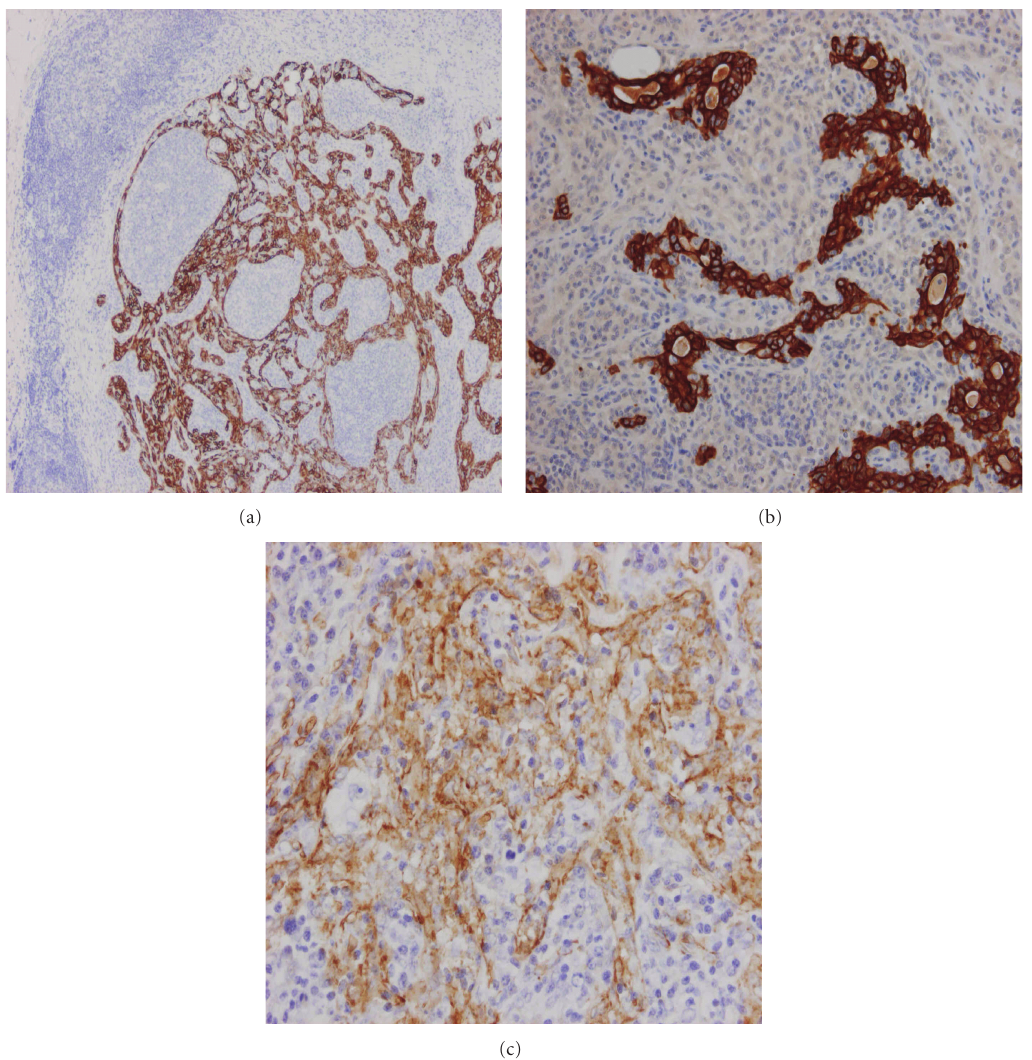
Figure 3: (a) Lymph node metastasis: CK5 staining both epithelial and myoepithelial elements. (b) Lymph node metastasis: CK19 staining epithelial element. (c) Lymph node metastasis: smooth muscle actin staining myoepithelial